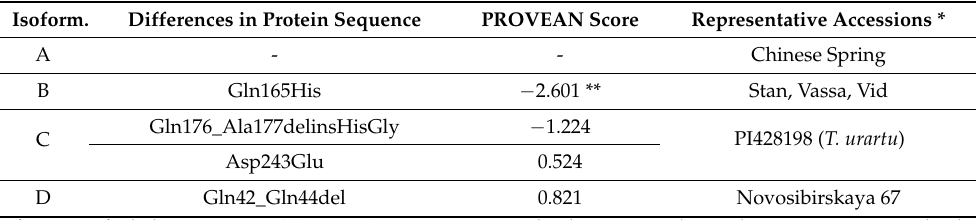
Table 1. GRF3-2A protein isoforms and functional significance of amino acid differences. Isoform.